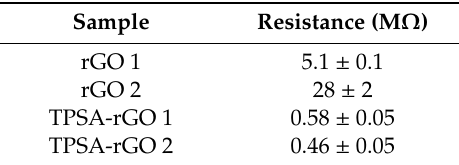
Table 2. Resistance of rGO and TPSA-rGO dispersed in chloroform as the average of three replicates ± standard